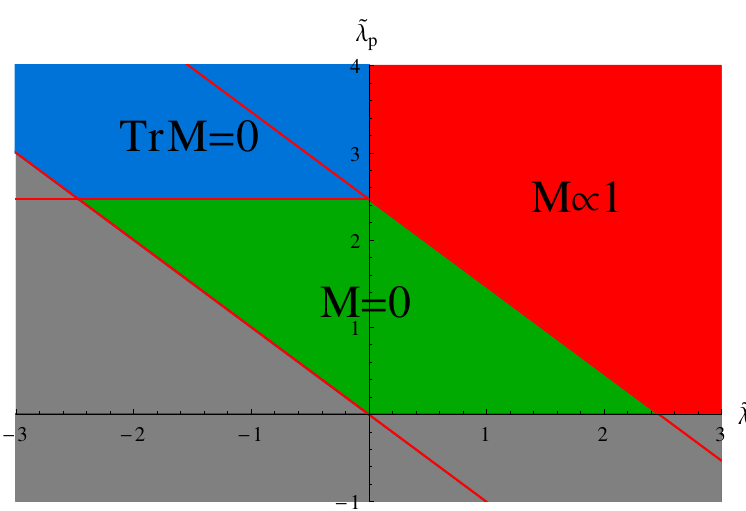
Figure 5 . Phase diagram of the fermionic TGN model in 3 d . The red zone has a vacuum M / 1 , the blue one to a traceless vacuum and the green parallelogram to M = 0. The grey zone corresponds to an unstable